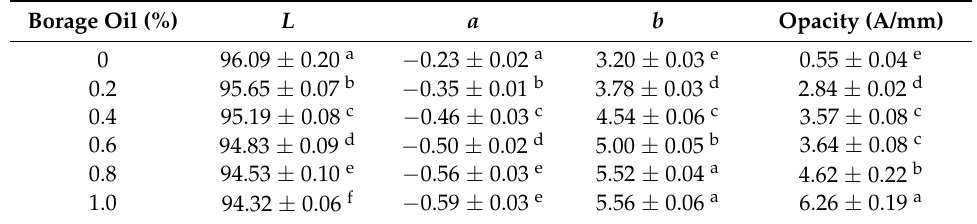
Table 3. Optical properties of the BMS films containing